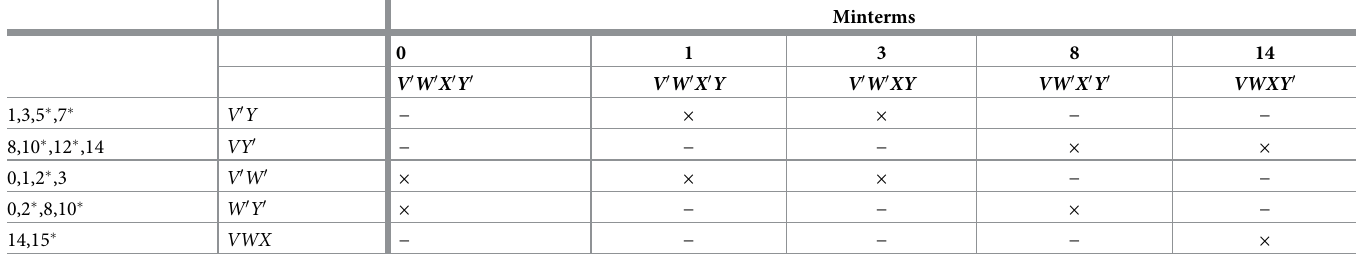
Table 3. Prime implicant chart for function table in Table